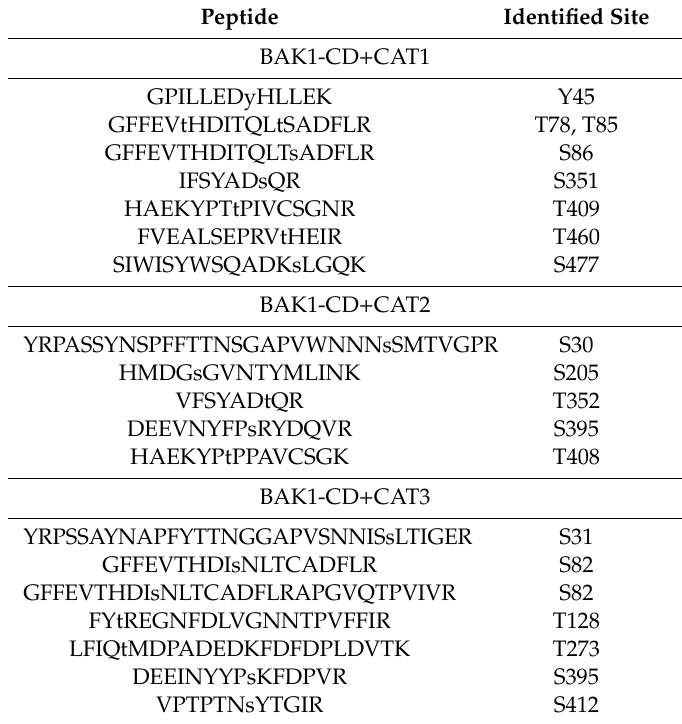
Table 1. Identification of Catalase (CAT) Phosphorylation Sites by LC / MS / MS in vitro.